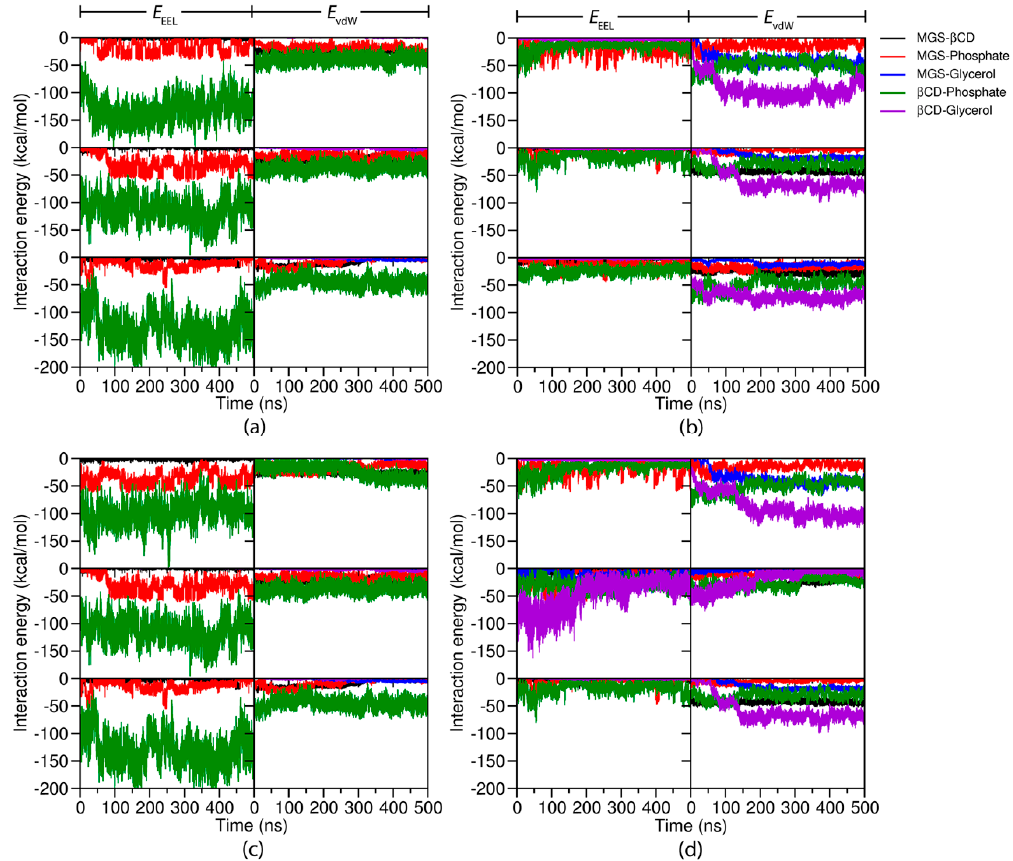
Figure 7. The electrostatic ( E EEL ) and van der Waals ( E vdW ) interactions for ( a ) A-MGS / β CD, ( b ) A-MGS / DM β CD, ( c ) C-MGS / β CD, and ( d ) C-MGS / DM β